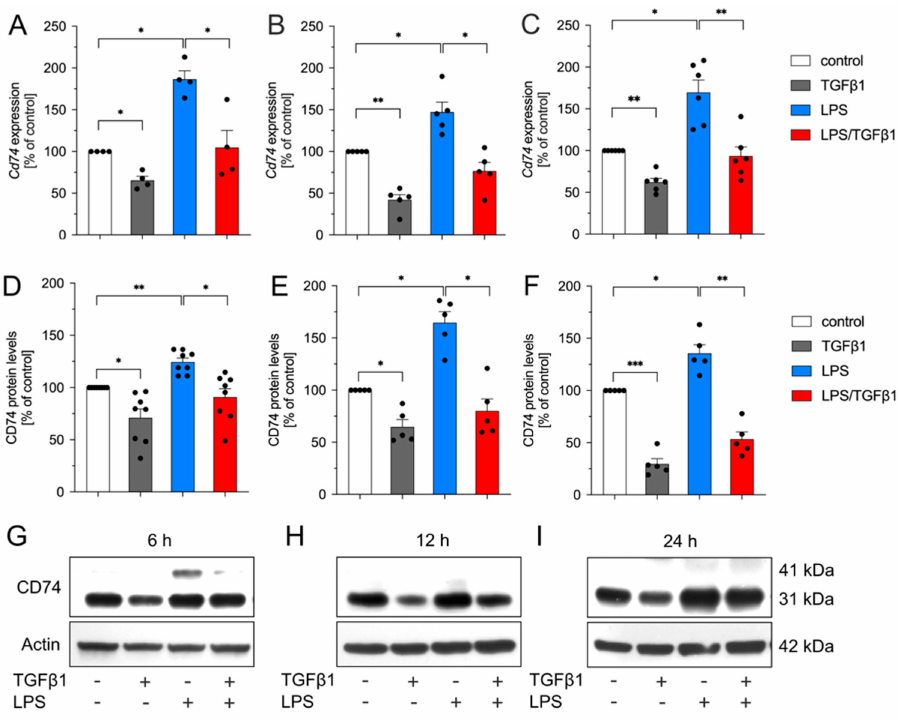
Figure 1. TGF β 1 inhibits LPS-mediated upregulation of Cd74 in BV2 cells. Expression of Cd74 after treatment of BV2 cells with TGF β 1 (5 ng/mL), LPS (1 µ g/mL), or both factors for 6 h ( A ), 12 h ( B ), and 24 h ( C ). Quantification of CD74 total protein levels after treatments for 6 h ( D ), 12 h ( E ), and 24 h ( F ). ( G – I ) Representative western blot images for each experimental time point. Data are given as means ± SEM for at least four independent experiments. p -values derived from one-way ANOVA followed by Tukey’s multiple comparison tests are shown as follows: * p < 0.05, ** p < 0.01, and *** p <